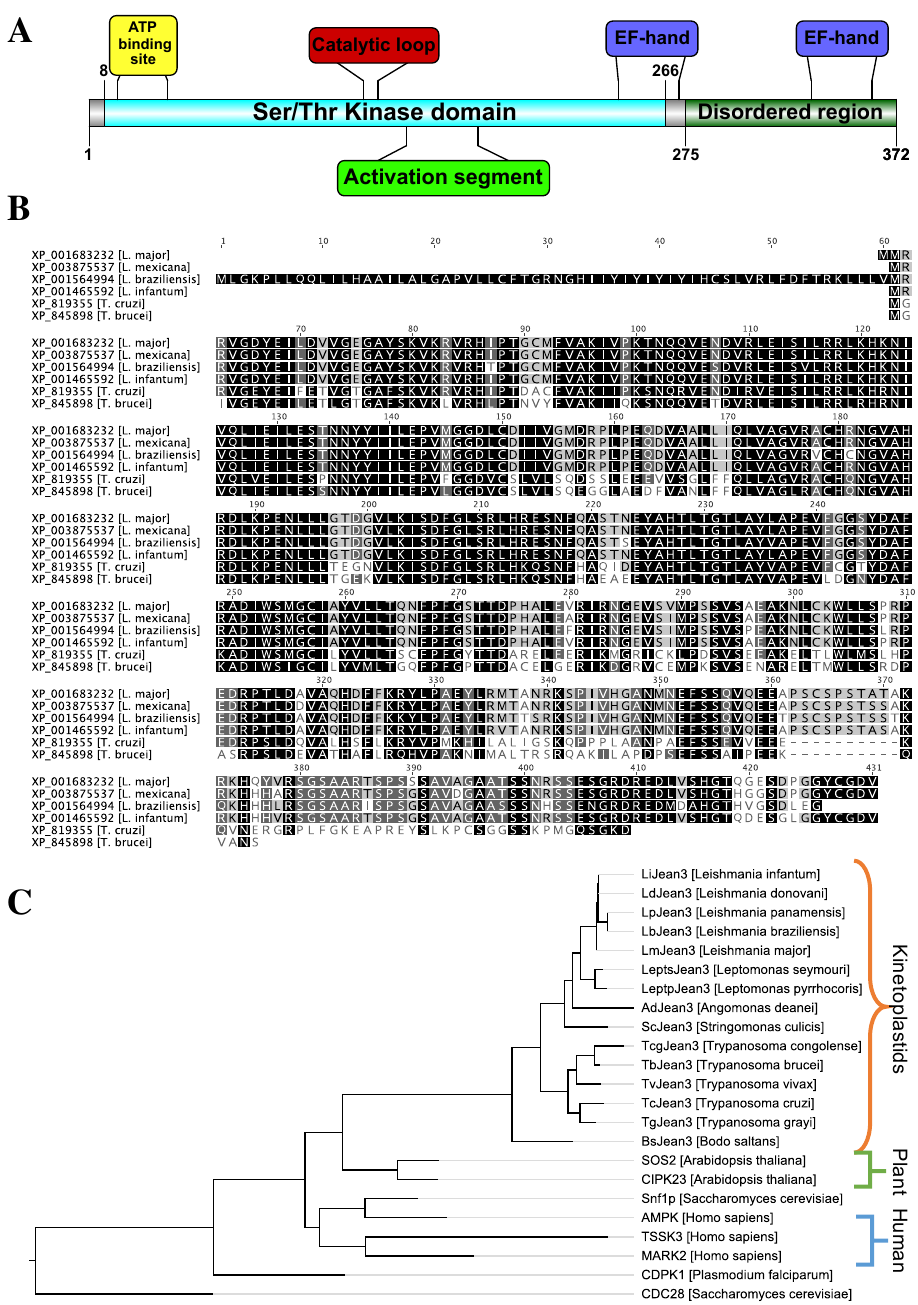
Figure 1. Homologues of LmjF.22.0810 (LmJean3) kinase are highly conserved in trypanosomatids. ( A ) Schematic representation of the predicted catalytically relevant regions and domains of LmJean3; ( B ) Leishmania major , Leishmania mexicana , Leishmania braziliensis , Leishmania infantum , Trypanosoma cruzi , and Trypanosoma brucei Jean3 orthologs sequences alignment. Residues are colored on the basis of